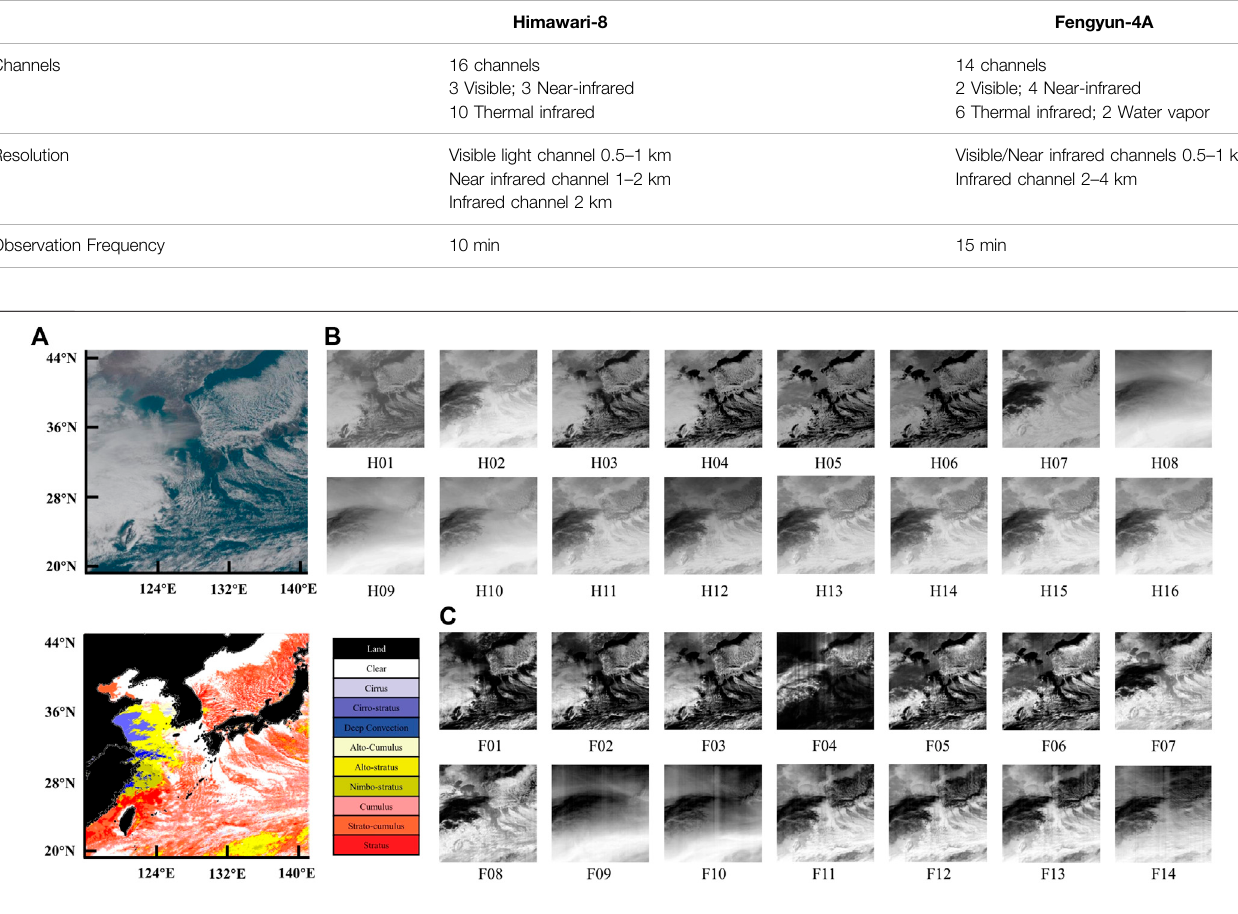
FIGURE 1 | (A) Red-Green-Blue image generated from Himawari-8 satellite data, GT images, and the types of cloud on 6 February 2020 at 05:00 UTC (08: 00 Beijing Standard Time) (B) Gray-scale images of Himawari-8 formed by one channel of remote sensing data, in range of H01 to H16 (C) Gray-scale images of Fengyun-4 formed by one channel of remote sensing data, in range of F01 to F14.